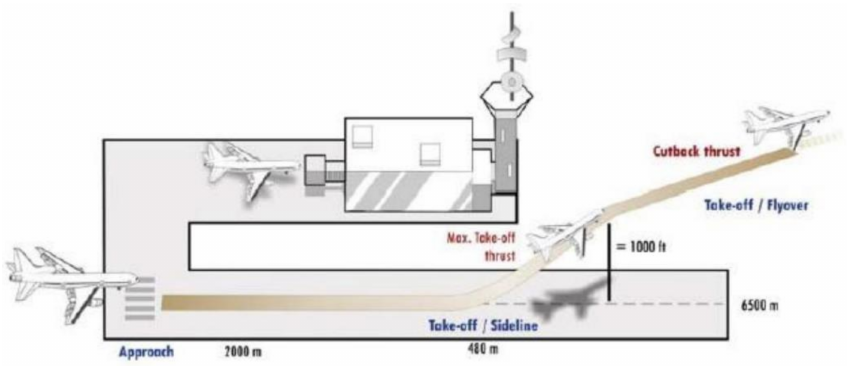
Figure 2. ICAO Certification Points reprinted from